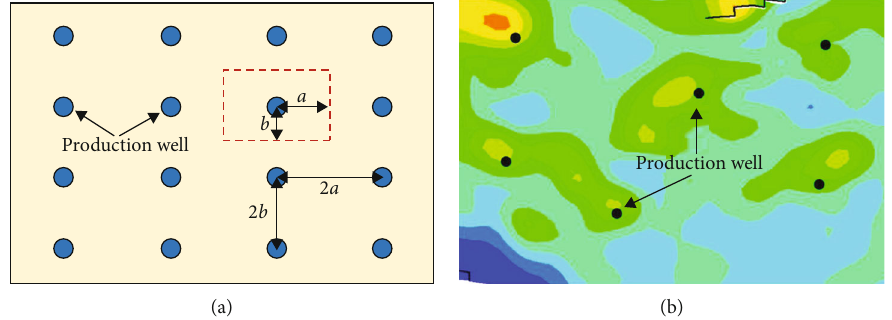
Figure 1: Reservoir models that have multiple production wells: (a) regular well distribution in a homogeneous reservoir and (b) irregular well distribution in a heterogeneous reservoir.